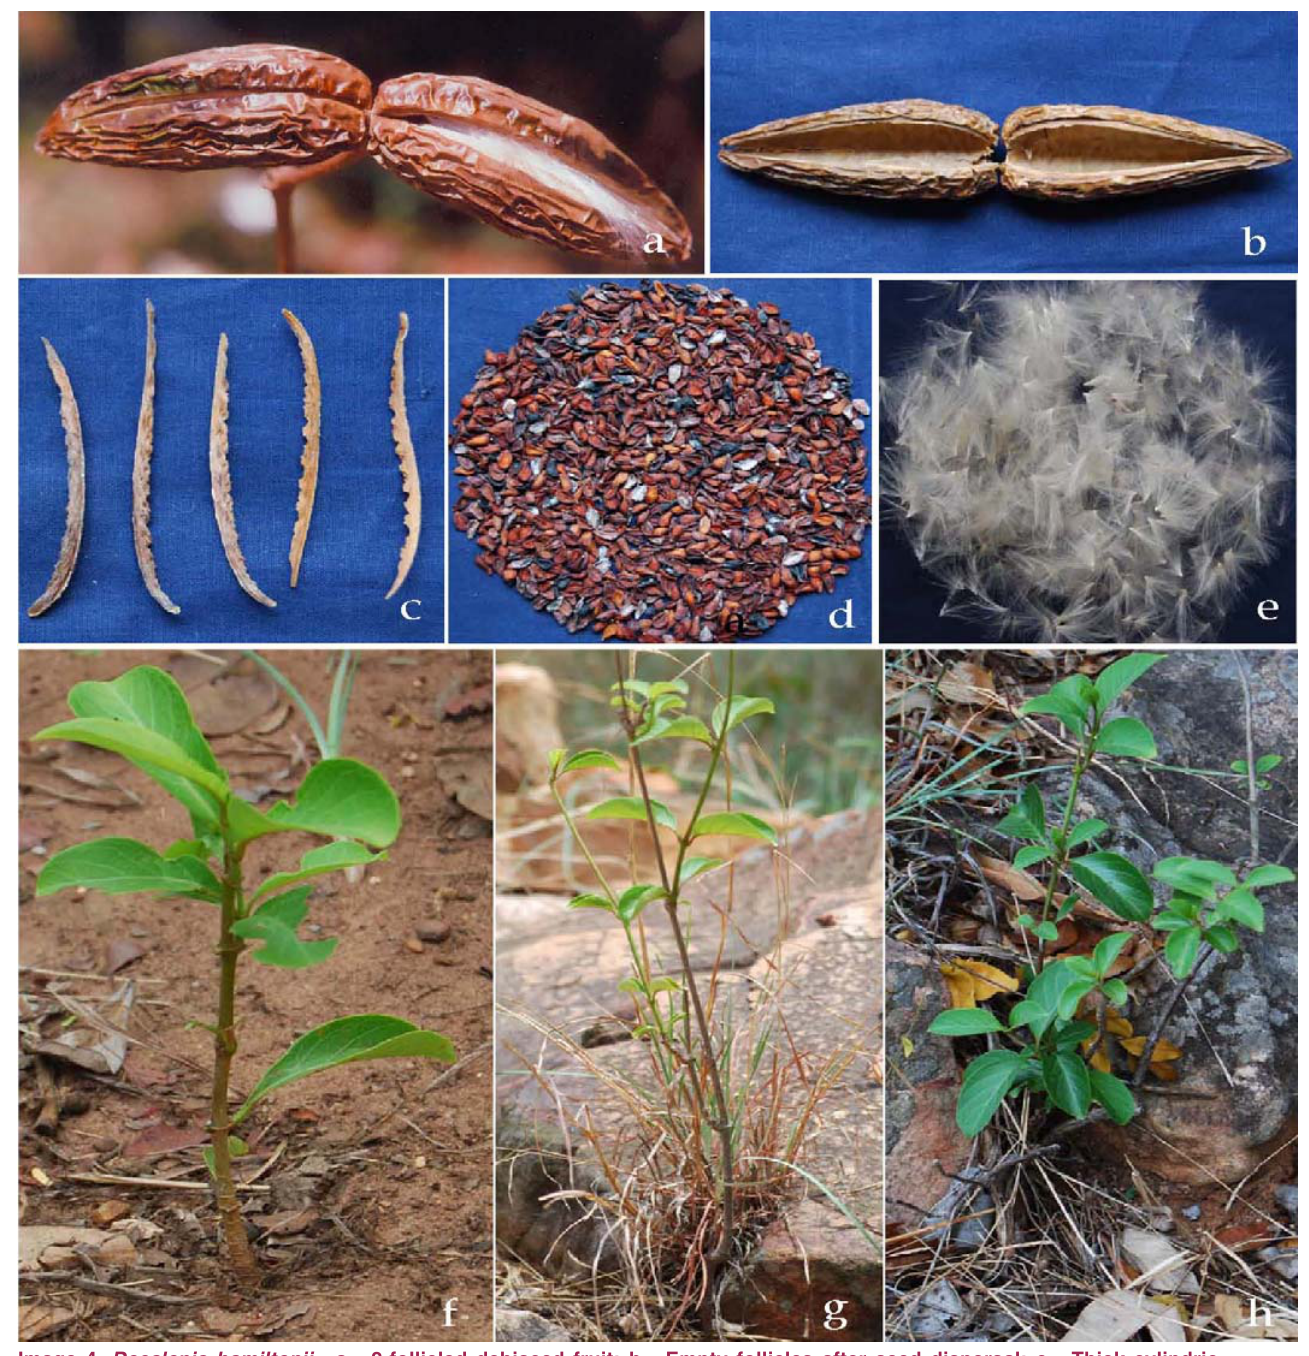
Image 4. Decalepis hamiltonii . a - 2-follicled dehisced fruit; b - Empty follicles after seed dispersal; c - Thick cylindric denticular placenta; d - Ripe and dry reddish brown seeds; e - A tuft of long silky white hairs of seed; f-h - Natural seedling establishment in litter and rocky habitats in the study